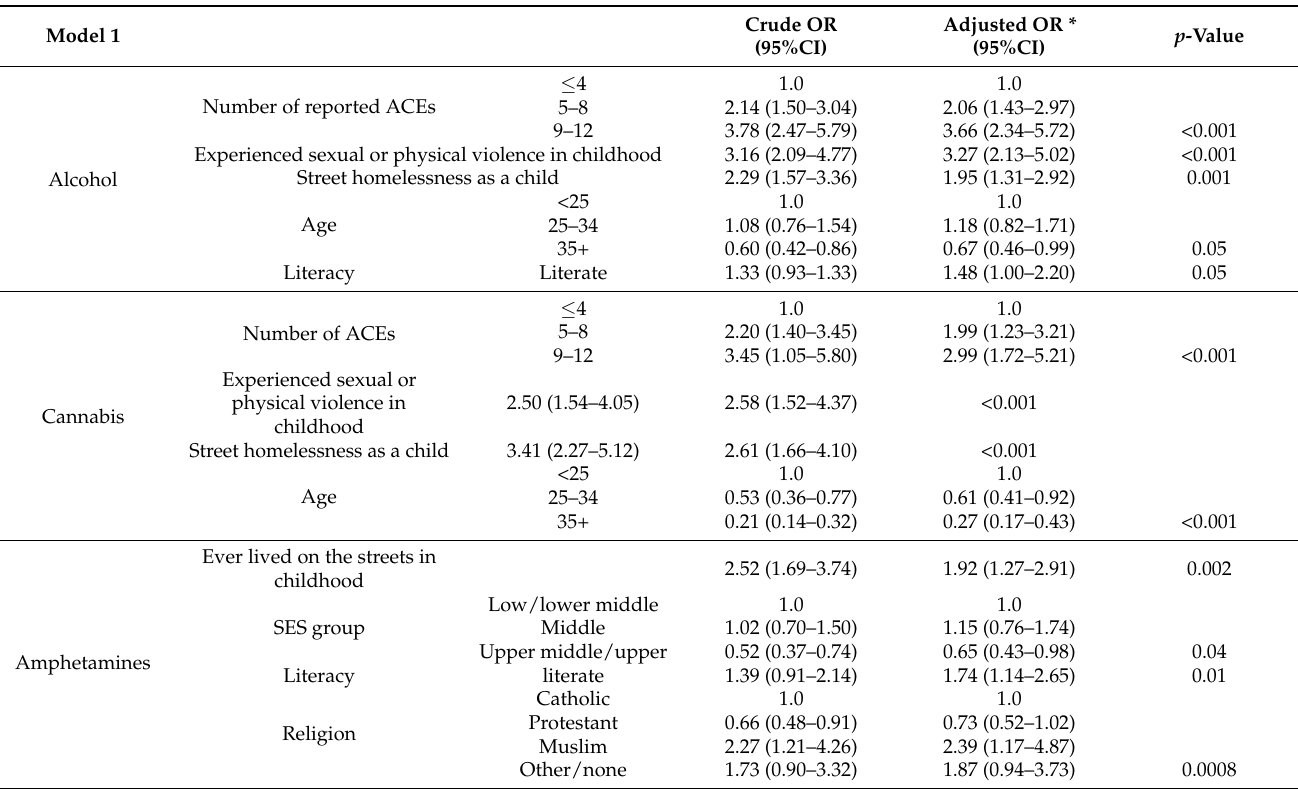
Table 2. Multivariable logistic regression—associations with alcohol/substance use and level 1 var- iables.